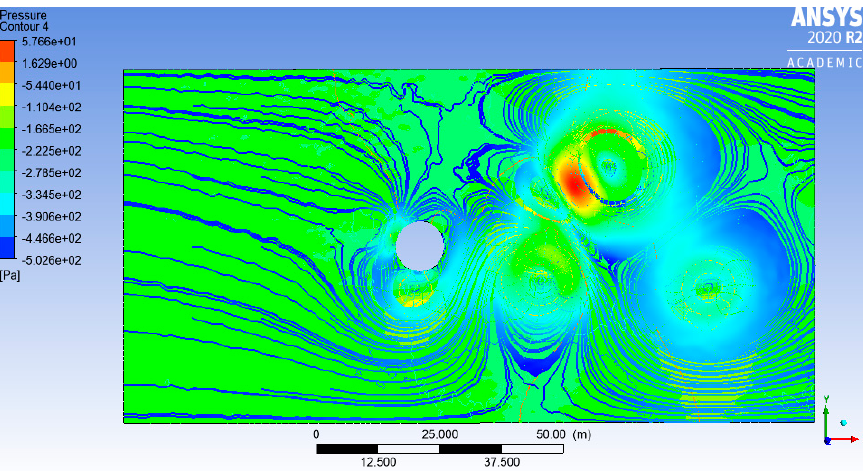
Figure 17. Pressure contour for the flow on the free-floating buoy under 1.5 m/s case.